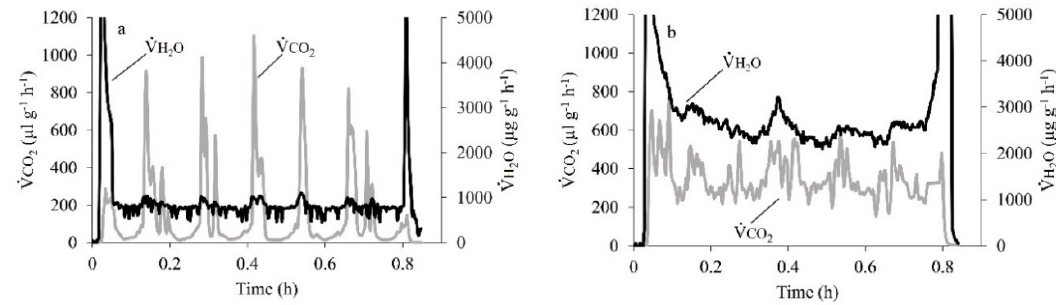
Figure 2. Metabolic rate, (cid:1848)(cid:4662) (cid:3004)(cid:3016) ( μ L g − 1 h − 1 ), and total evaporative water loss, (cid:1848)(cid:4662) (cid:3009) (cid:3118) 2 (cid:3118) measured over time for an individual cockroach showing the discontinuous gas exchange (DGE) pattern ( a ) and for an individual beetle showing continuous gas exchange (CGE) pattern ( b ). Within the same species, the metabolic rate of cockroaches showing DGE (195 ± 8.2 μ L g − 1 h − 1 )